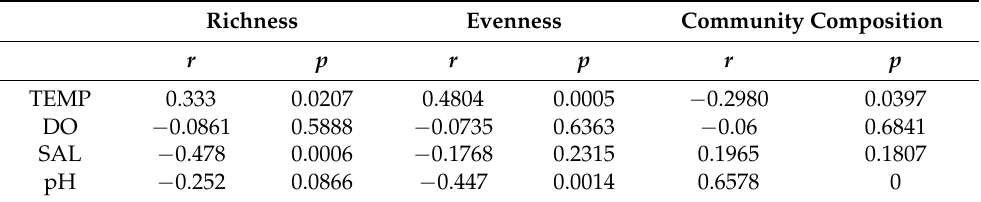
Table 1. Correlation coefficient ( r ) for ciliate diversity and environmental parameters. A p -value of <0.05 was considered statistically